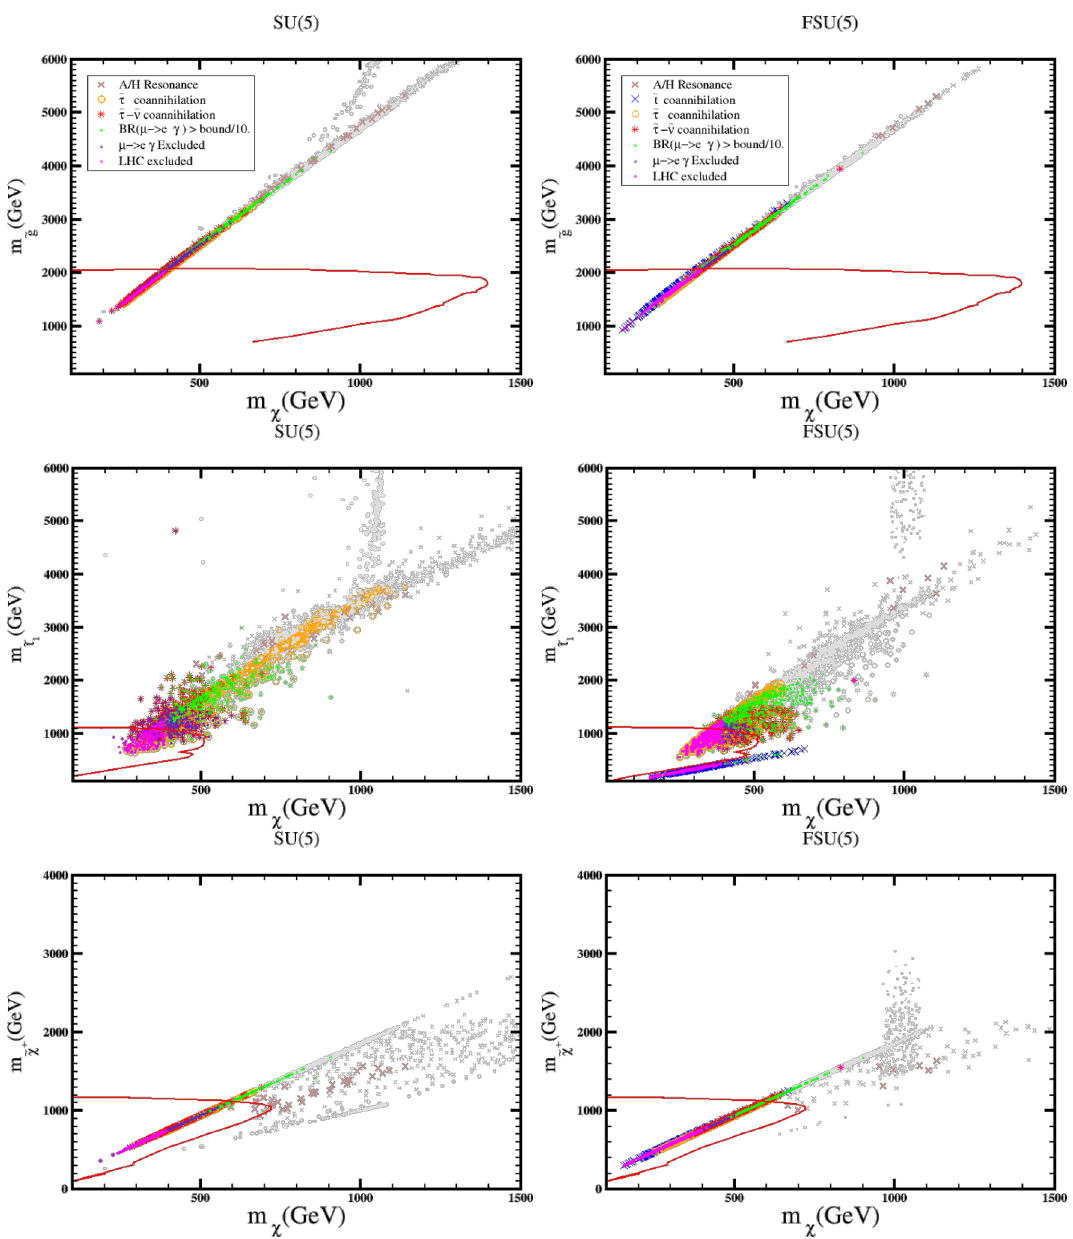
Figure 6 . LHC prospects for the SU5 and FSU5 models. The points follow the notation of (cid:12)gures 3, 4 and 5. The meanings of the solid red lines are explained in the text. Indigo crosses indicate points excluded by the limit on BR( (cid:22) ! e(cid:13) ), whereas the green crosses mark points that lie between the current bound and one order of magnitude below it.